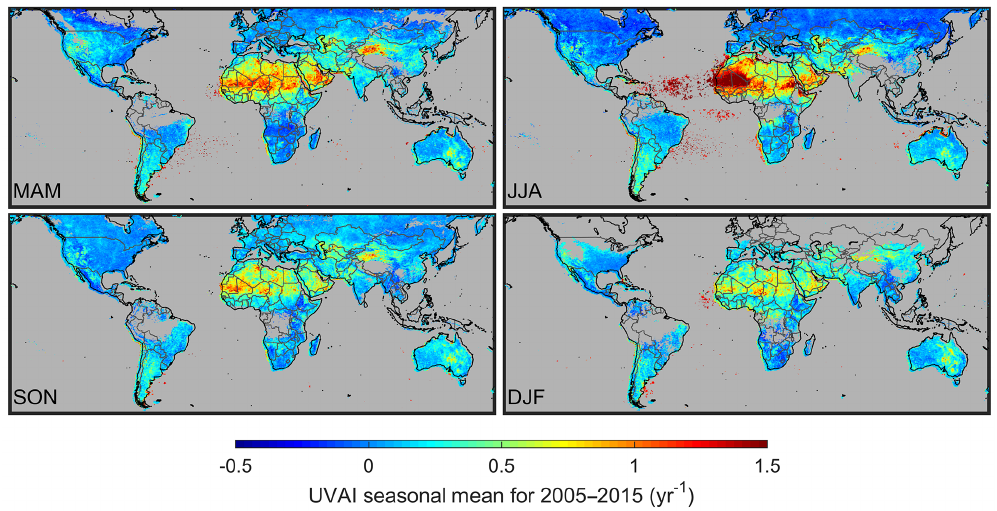
Figure 2. Seasonal mean UVAI values for the 2005–2015 period as observed by OMI for MAM (May, April, March), JJA (June, July August), SON (September, October, November), and DJF (December, January, February). Grey indicates persistent cloud fraction greater than 5%.